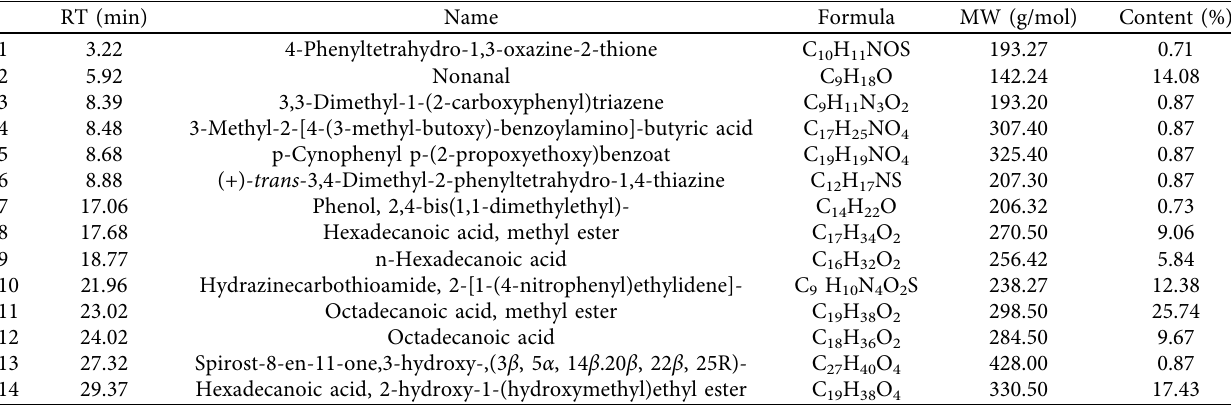
Table 6: Chemical composition of tunichrome released from Phallusia nigra Persian Gulf marine tunicate by GC-MS. RT (min)